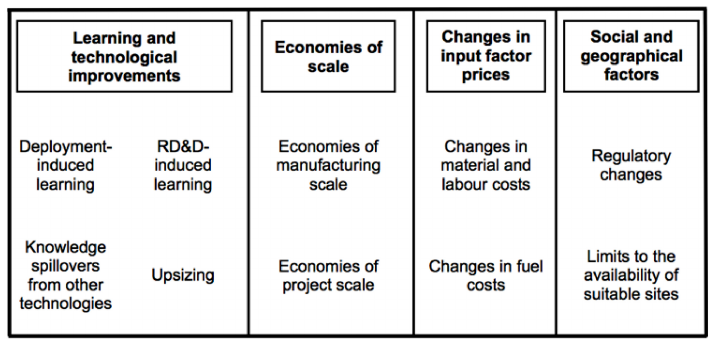
Figure 1. Factors influencing the market costs of electricity generation technologies as identified by the literature review.